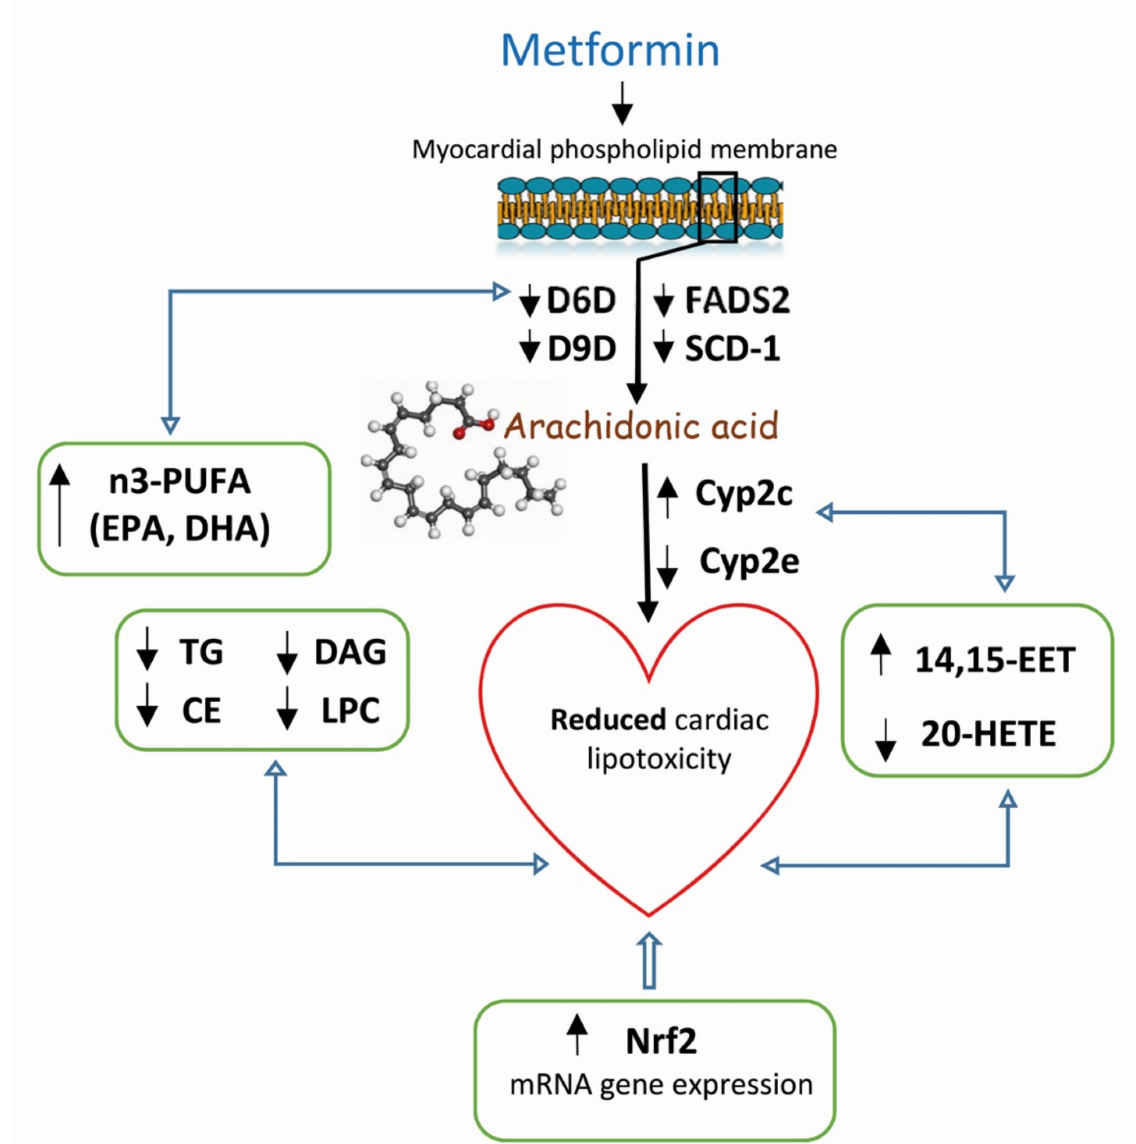
Figure 6. Putative involvement of metformin in cardiac arachidonic metabolism, CYP-derived arachidonic acid metabolites and some cytochrome P450 proteins. The alterations in AA metabolism is manifested in the form of elevated production of anti-inflammatory 14,15-EET, produced by Cyp2c and inhibited formation of pro-inflammatory 20-HETE, produced by Cyp2e. In addition, reduced SCD-1 expression with an inhibited D9D activity index in the myocardium contributes to reduced myocardial accumulation of neutral lipids and toxic lipid intermediates, respectively. Affecting the desaturation system is associated with an altered fatty acid profile in membrane phospholipids in the myocardium, which contributes to an increased proportion of n3-PUFA, resulting in increased membrane fluidity. All these changes, together with markedly elevated Nrf2 expression, contribute to the reduction of cardiac lipotoxicity and